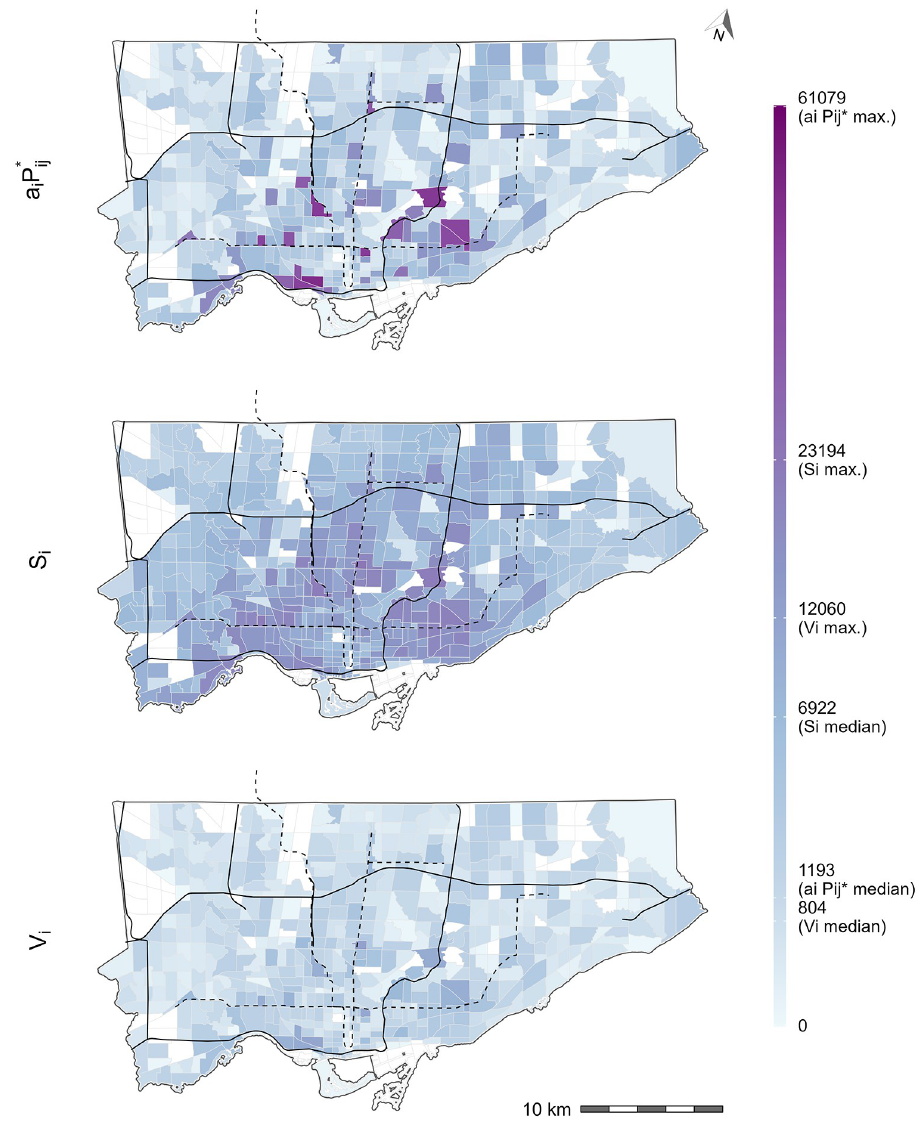
Fig 7. Estimated accessibility to jobs (# of jobs) in Toronto according to Shen-type measure multipled by the effective opportunity-seeking population (top), Hansen-type measure (middle), and spatial availability (bottom). Black lines represent expressways and black dashed lines represent subway lines. All white TAZ have no worker population or jobs, i.e., with null accessibility values. Legend scale is square root transformed to effectively visualize the range of